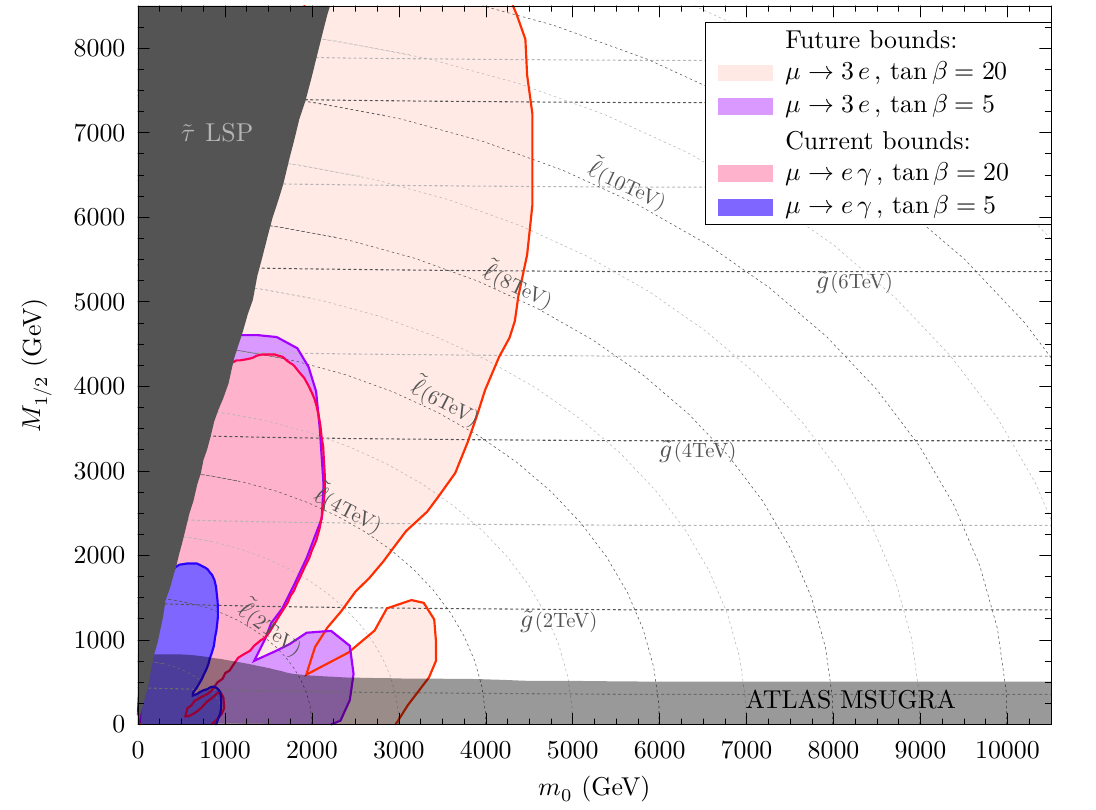
Figure 6 . Excluded regions due to (cid:22) ! e(cid:13) and (cid:22) ! eee for two reference values: tan (cid:12) = 5 (blue shapes) and tan (cid:12) = 20 (red shapes). In the dark (blue and red) regions, we compare with current (cid:22) ! e(cid:13) bounds, while in the light (blue and red) regions we compare with the expected (cid:22) ! eee sensitivity in the near future. Interestingly, even for present bounds, these results are competitive with mSUGRA ATLAS limits (gray